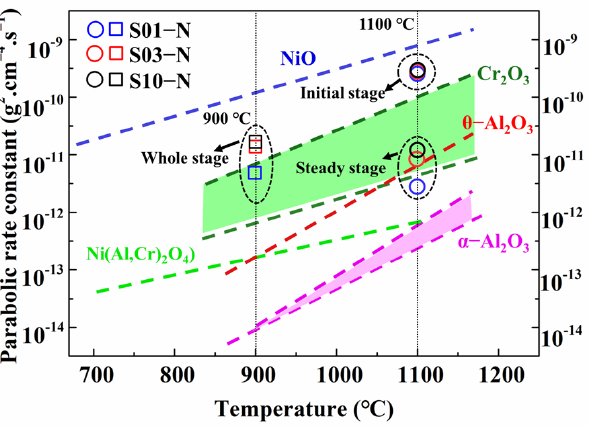
Figure 6. Comparison of the parabolic rate constants k p for the specimens of IC21 alloy with different thicknesses at 900 °C and 1100 °C with the k p for pure oxides varied with the temperature [24].